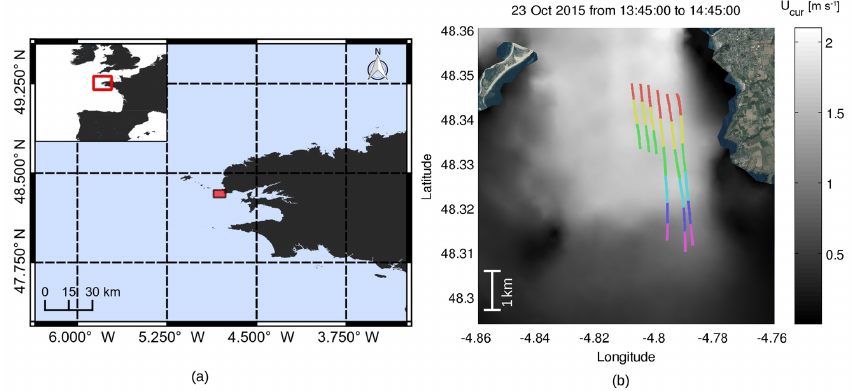
Figure 6. Study field location and local experimental conditions. (a) Chenal du Four location. (b) Local current condition and drifter path. The current field shown here comes from a barotropic model simulation at 250m resolution (Lazure and Dumas, 2008; Pineau-Guillou, 2013). Colored lines shows the 10min SKIB displacement over the current gradient on 23 October 2015, 14:40UTC.